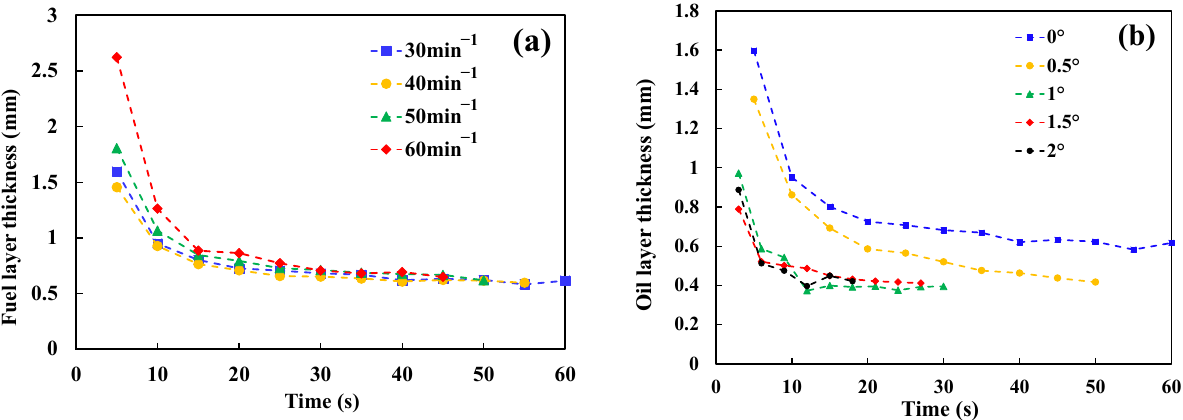
Figure 4. ( a ) Fuel layer thickness as a function of discharge times with a slope of 0°; ( b ) Fuel layer thickness as a function of the discharge times with the same discharge rate (30 rad/min).